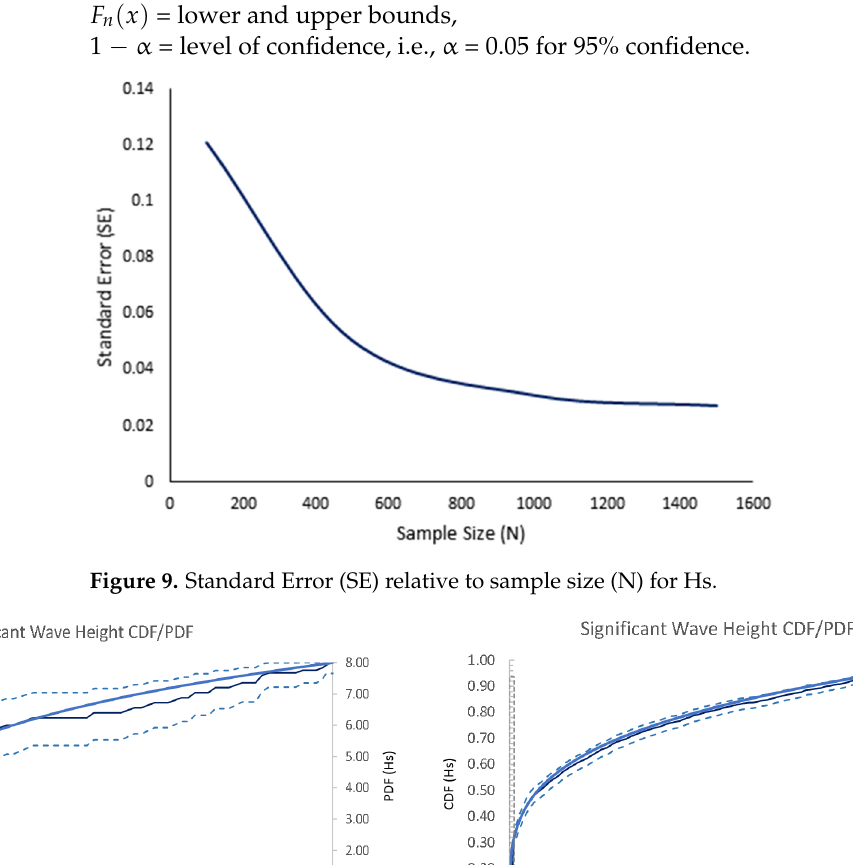
Figure 9. Standard Error (SE) relative to sample size (N) for Hs.